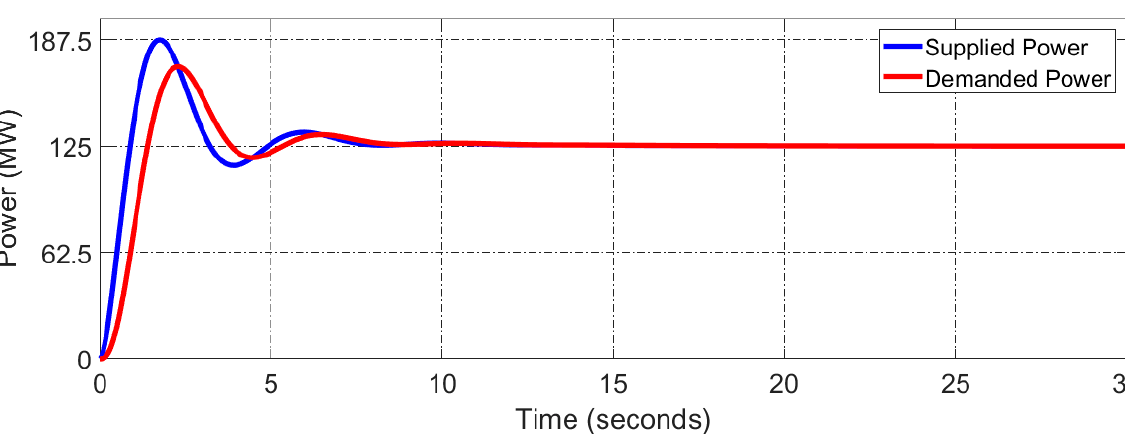
Figure 14. The active power mismatches between the supplied power and demanded power in the single-area.